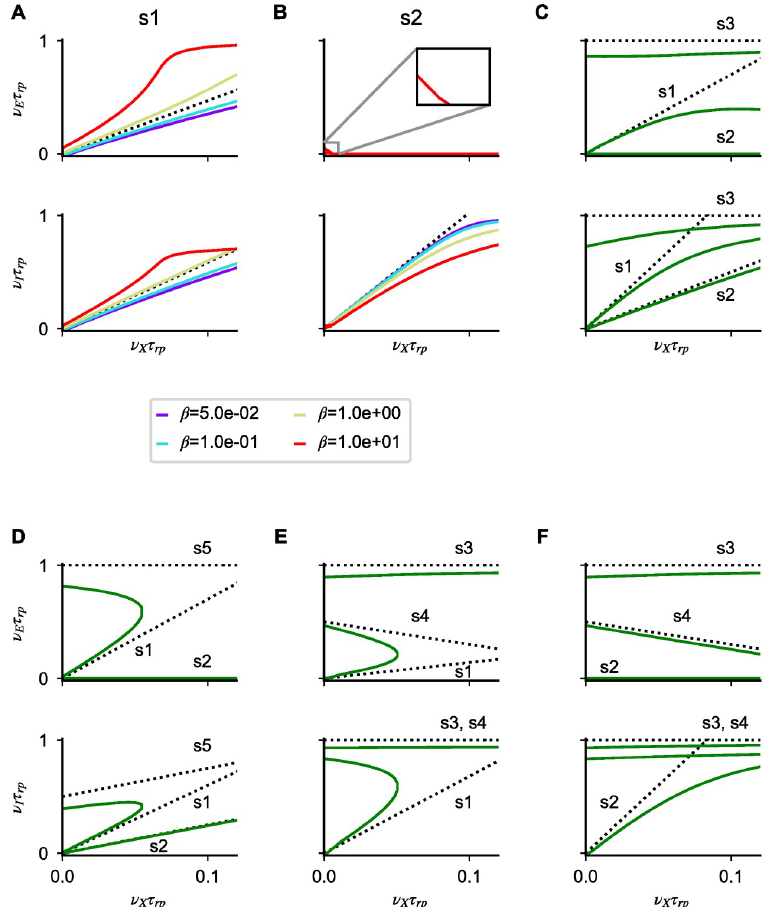
Fig 4. Saturation nonlinearities in model B. ( A - F )Numerical solutions of Eqs (3)–(5) for different parameters (colored lines) and linear approximations predicted by Eqs (24), (26) and (27) in the strong coupling limit (dotted lines). In each panel, the first (second) row shows the excitatory (inhibitory) firing rate as a function of ν . ( A , B ) X Nonlinear solutions obtained at finite coupling starting from solution s1 and s2 for different β values. ( C - F ) All admissible cases of coexistence of multiple solutions at low ν ; note that, as expected from our analysis, the number of X solutions changes as ν X increases. Simulation parameters are: ( A ) g I = 3.9, g E = 8, α I = 1 α E = 7; ( B ) g I = 3.9, g E = 8, α I = 10, α = 7; ( C ) g = 4, g = 3, α = 5, α = 2; ( D ) g = 8, g = 6, α = 5, α = 2; ( E ) g = 1, g = 2, α = 0.3, α = 2; ( F ) g = 1, E I E I E I E I E I E I E I g E = 2, α I = 3, α E = 2. In panels ( A - F ), g EX = g IX = 1; J EE = J IE = 0.2 mV and K EE = K IE = 10 3 ; except in A and B where ffiffiffi p ffiffiffi p ¼ b 10 3 , K ¼ 10 3 = b K EE IE